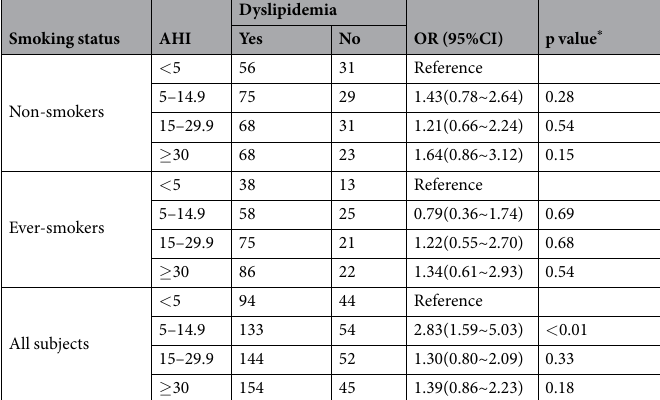
Table 3. Odds ratios of dyslipidemia at different OSAS severity groups as compared to normal subjects. Abbreviations: OSAS, obstructive sleep apnea syndrome; AHI, apnea-hypopnea index; CI, confidence interval. * p value was calculated from Pearson χ 2 test.